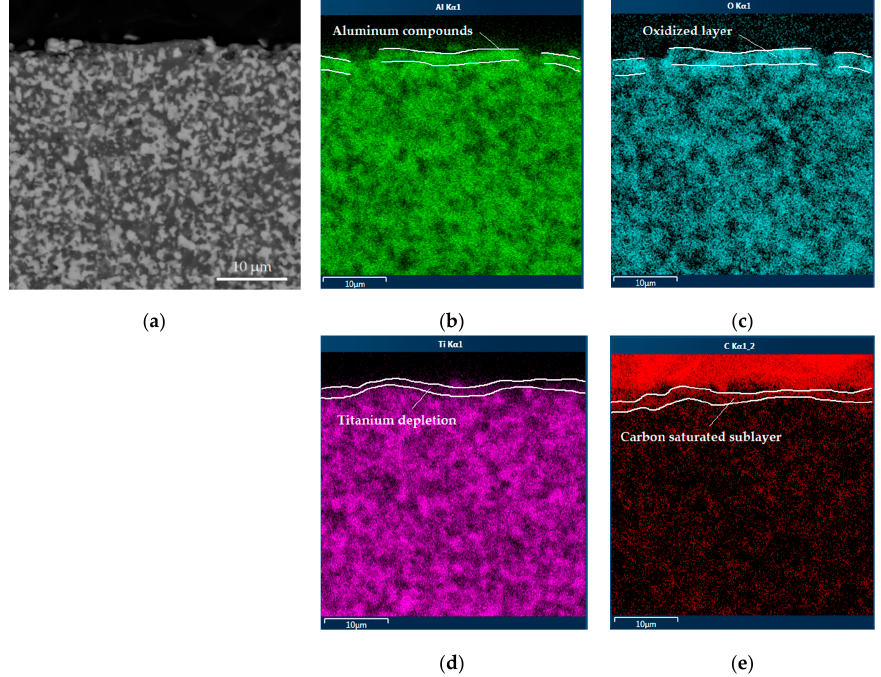
Figure 10. Microstructure and elemental mapping of the Al 2 O 3 + 30%TiC nanocomposite machined in water medium: ( a ) Microstructure in back-scattered electrons (BSE), 5.0 k×; ( b ) Aluminum; ( c ) Oxygen; ( d ) Titanium; ( e ) Carbon.